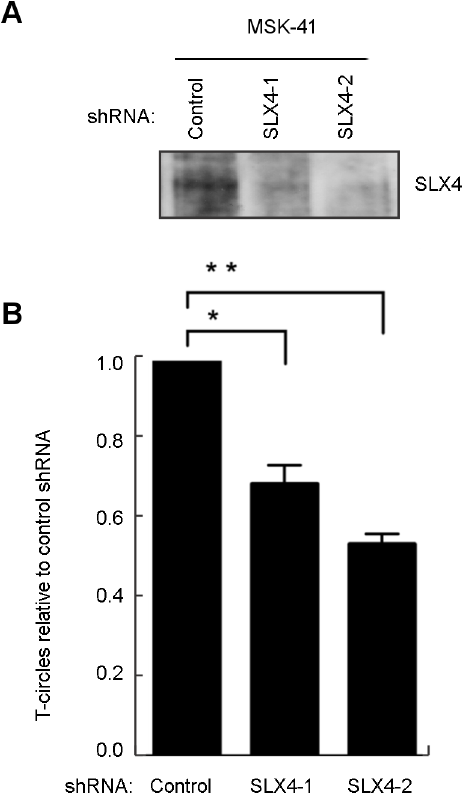
Figure 5. T-circle formation in MSK-41 cells is dependent on SLX4. (A) Two shRNAs (SLX4-1 and SLX4-2) were used to knockdown SLX4 expression. (B) T-circle formation was measured in the MSK-41 SLX4 knockdown strains relative to MSK-41 with a control shRNA. Mean and standard deviation were calculated from two independent experiments. *P , 0.05, **P , 0.01 by unpaired two-tailed t-test.